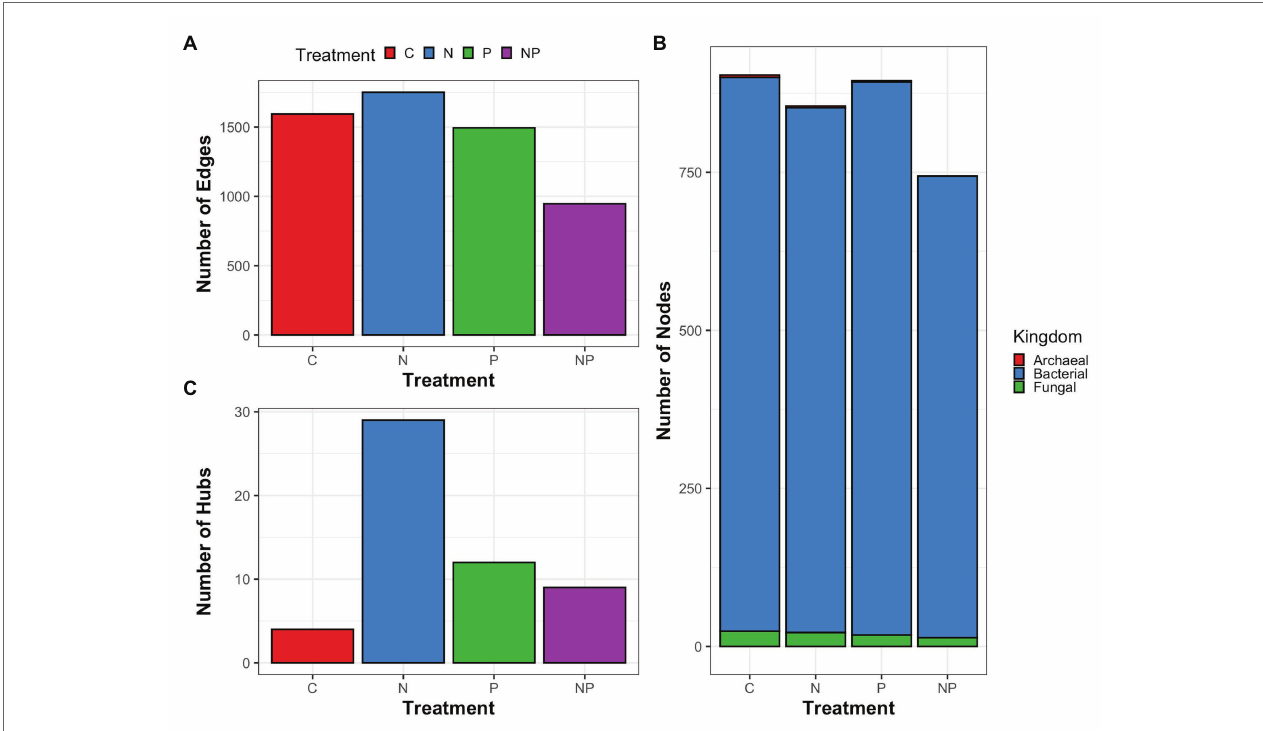
FIGURE 6 | Summary of cross-domain correlation networks of periphyton archaea, bacteria, and fungal associations (edges; A ) between microorganisms (nodes; B ) as well as taxa with significantly higher interactions than other nodes (hubs; C ) for control (C), nitrate (N), phosphate (P), and nitrate + phosphate (NP) nutrient exposure